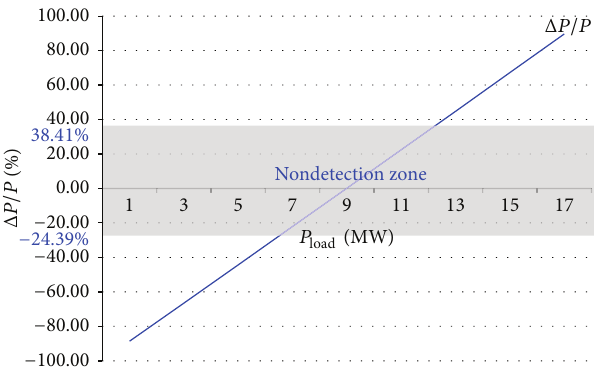
Figure 7: The changes of load affect entering or leaving the NDZ.